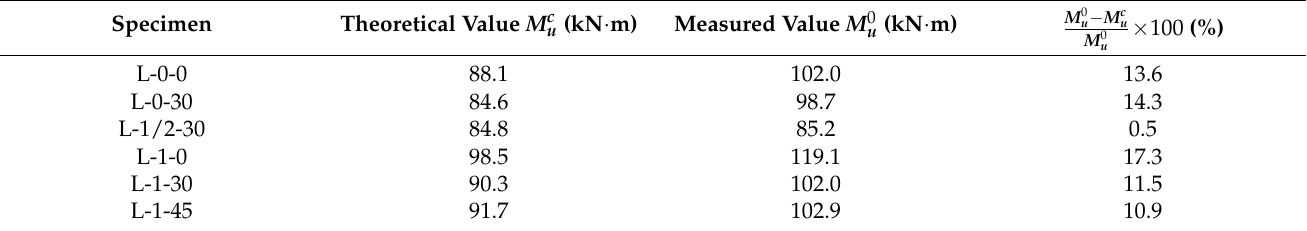
Table 7. Comparative analysis of the theoretical value M c u and the measured value M 0 u of the bending